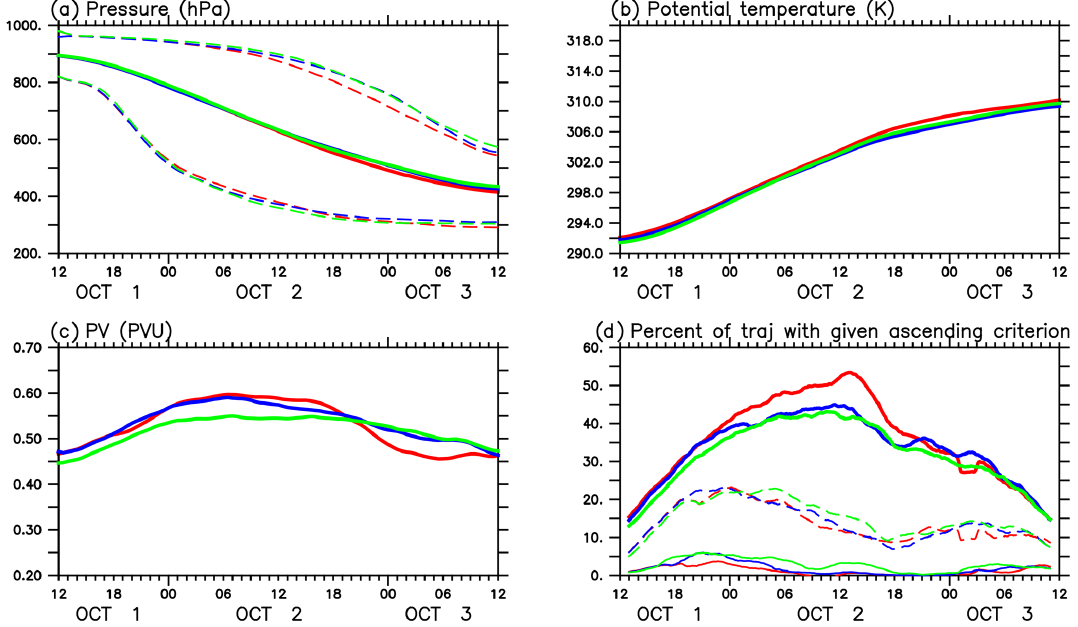
Figure 2. Time evolution along WCB trajectories of (a) mean pressure (solid lines, units: hPa) and the 10th and 90th percentiles of pressure (dashed lines), (b) mean potential temperature (solid lines; units: K), and (c) mean PV (units: PVU). Panel (d) indicates the percentage of WCB trajectories in each run satisfying a given ascending criterion at a given time: 100hPa in 2h (light solid lines), 50hPa in 2h (dashed lines) and 25hPa in 2h (bold solid lines). The red, blue and green curves correspond to B85, PCMT and NoConv simulations respectively.